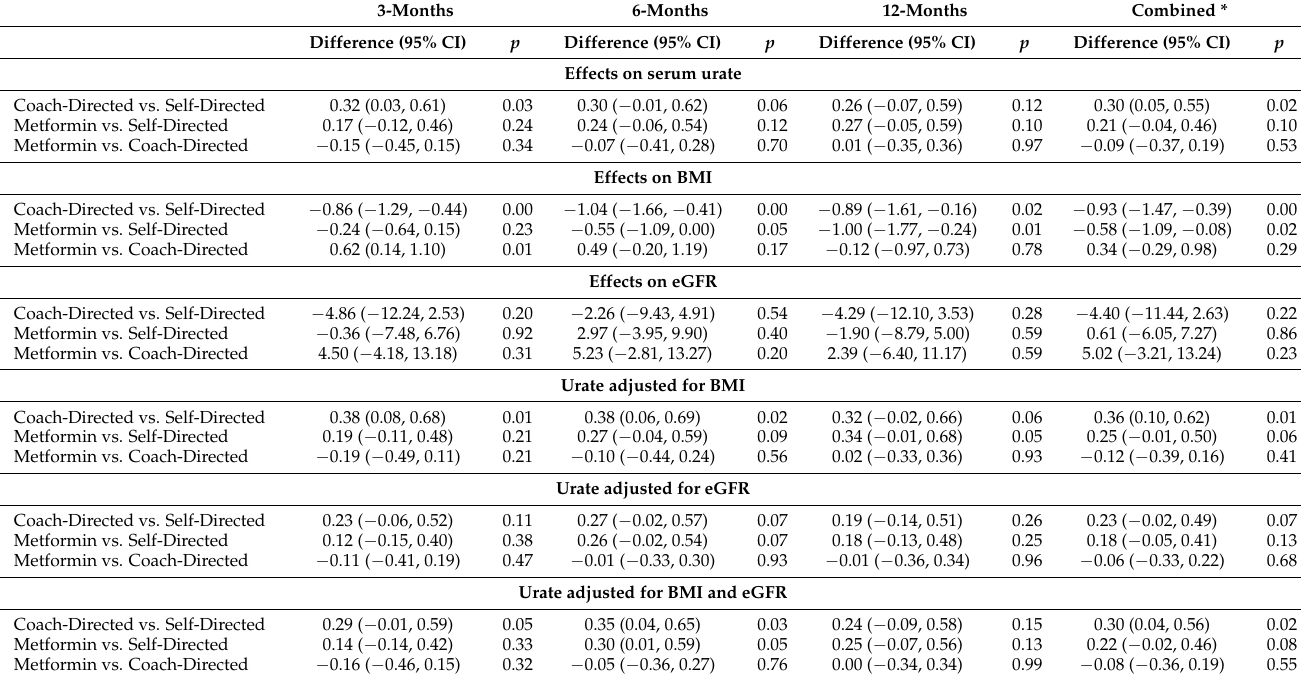
Table 3. Difference in serum urate level (SU, in mg/dL), body mass index (BMI, in kg/m 2 ), and estimated glomerular filtration rate (eGFR in mL/min/1.73 m 2 ) between treatment arms at 3 months, 6 months, and 12 months, with and without adjustment for BMI and